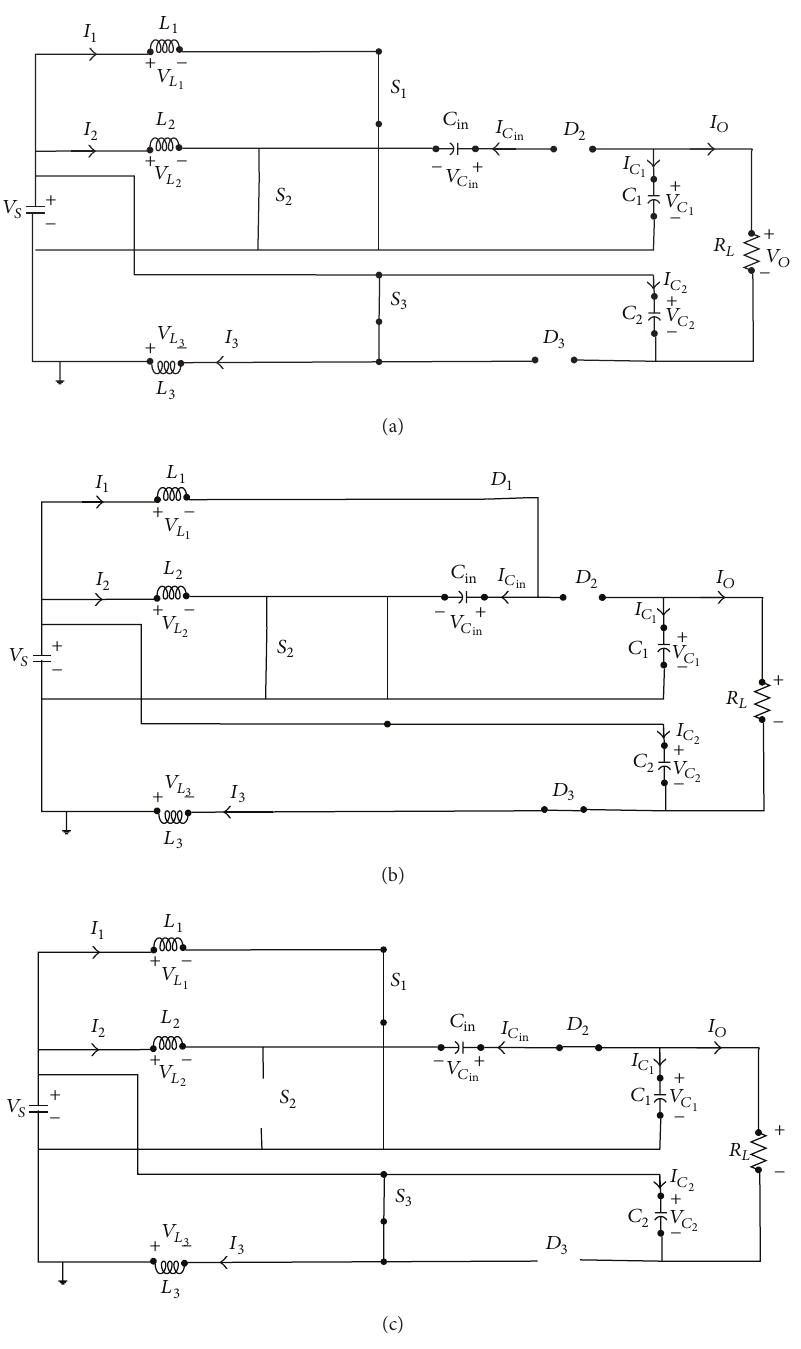
Figure 3: Operating circuits of the proposed converter. (a) State-I and state-III, (b) state-II, and (c) state-IV.